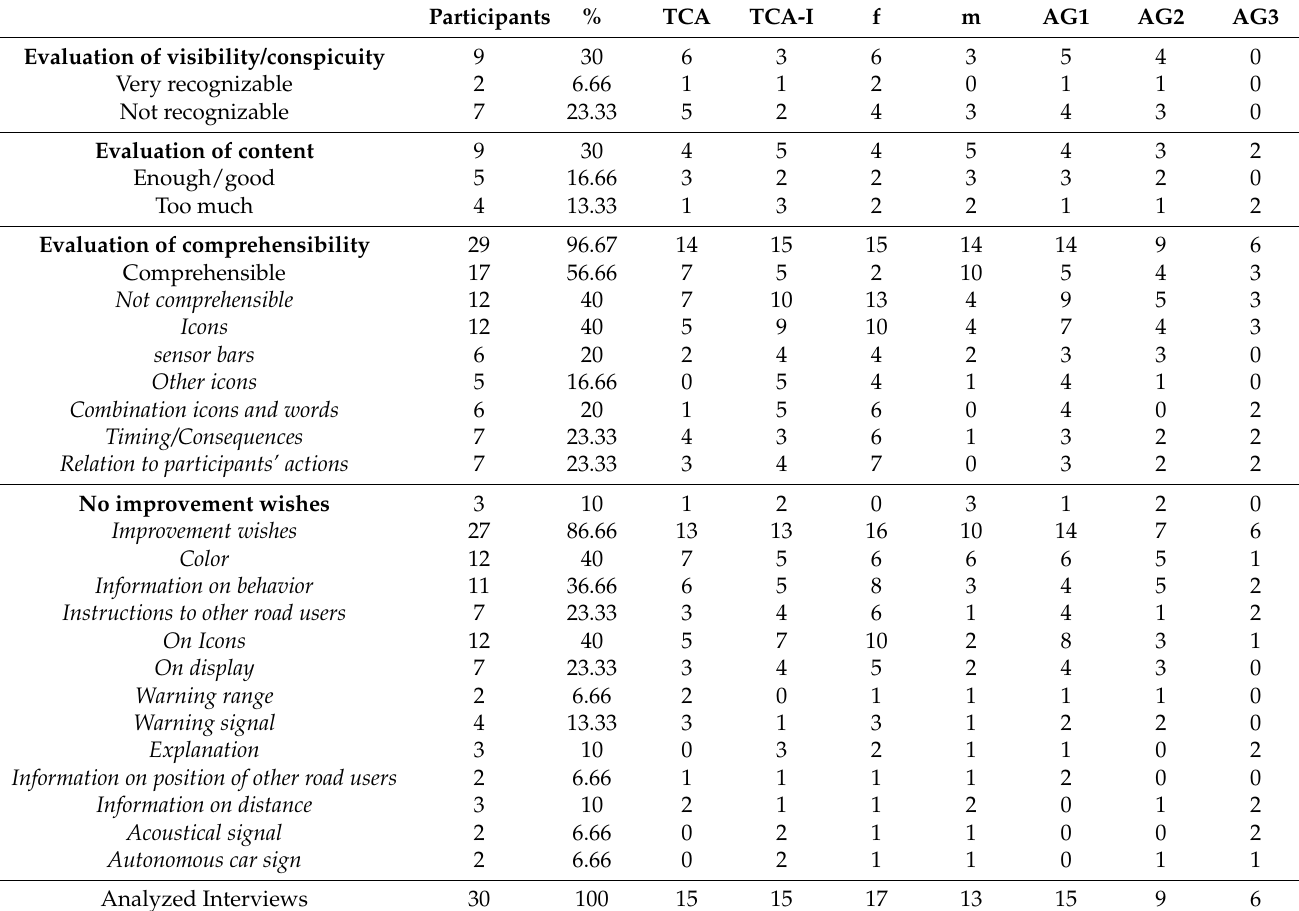
Table A6. Evaluation of the Communication Design and Improvement